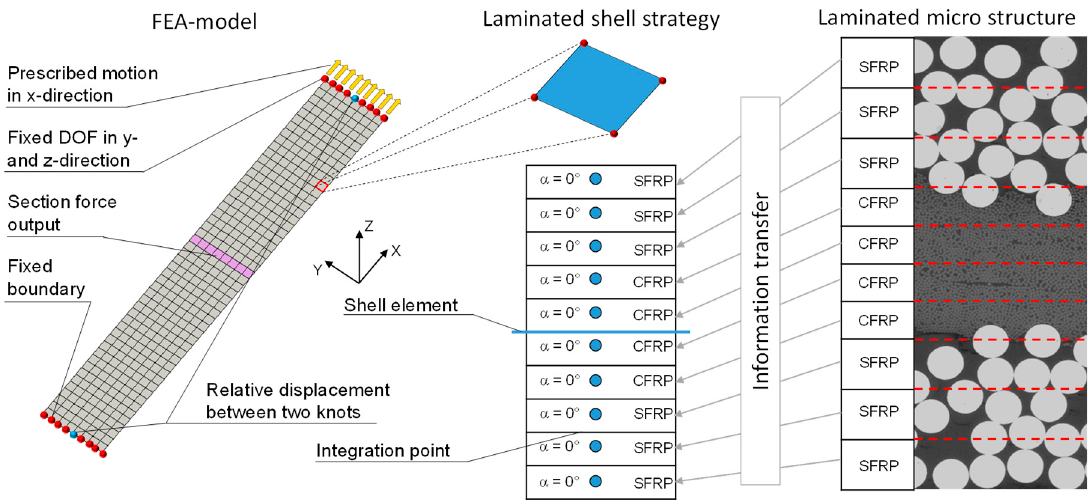
Figure 4. Overview of the FEA-model setup including the application of the laminated shell strategy and its linkage to the microstructure of the corresponding laminate. and its linkage to the microstructure of the corresponding